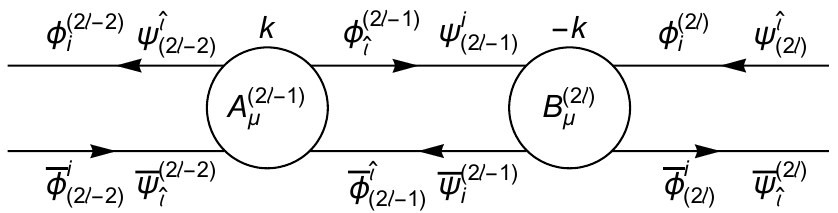
Figure 3. A slice of the quiver diagram of N = 4 orbifold ABJM theory with gauge group and levels [U( N ) k (cid:2) U( N ) (cid:0) k ] r . The quiver diagram is closed, so index identi(cid:12)cations (2 r +1) = (1) and (2 r ) = (0) are